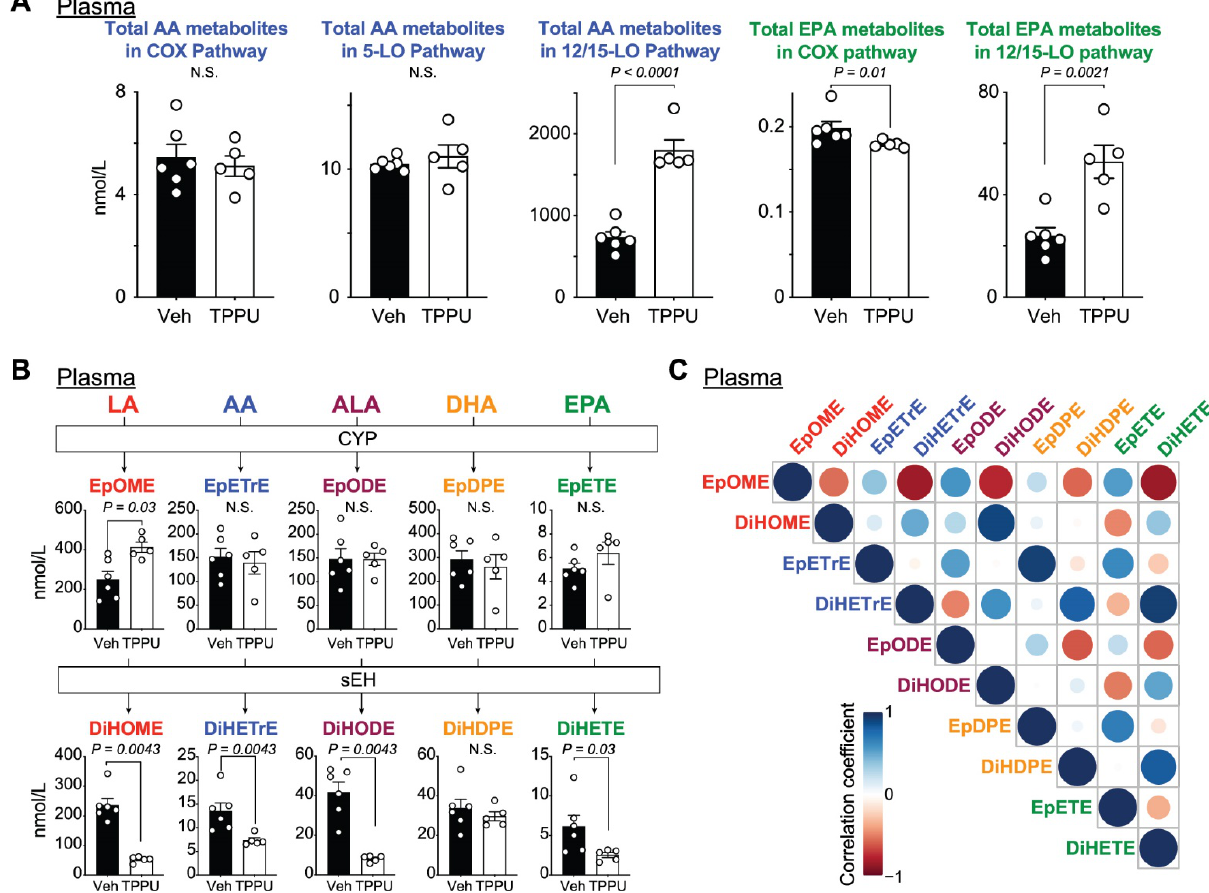
Figure 3. PUFA fluxes in EAE plasma. ( A ) Levels of arachidonic acid (AA) and eicosapentaenoic acid (EPA) metabolites in each pathway. ( B ) Levels of linoleic acid (LA), AA, alpha-linolenic acid (ALA), and docosahexaenoic acid (DHA) metabolites in the cytochrome P450 (CYP)-soluble epoxide hydrolase (sEH) pathway. ( C ) Correlation matrix of EpFAs and dihydroxy-FAs. P values were determined by t-test or Mann–Whitney U test. N.S., non-significant.